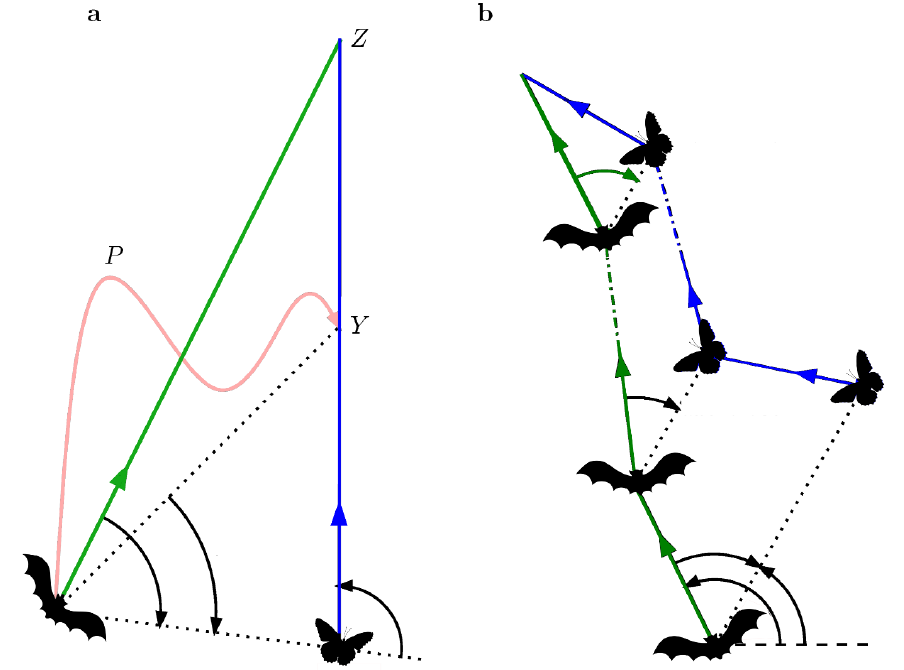
Figure 3. Modified from Ghose et al. 2006 [67]. ( a ) Constant bearing strategy (CB). Target (insect) moves in a straight line, at a constant velocity (blue line), and is pursued by bat that holds a fixed target bearing (green line), aiming where it will intercept the target (interception point Z). An alternative nonlinear path (pink) can be adopted by the bat when pursuing a target with constant linear velocity, resulting in a shorter intercept time at point Y (see Ghose et al. 2006 for further description). ( b ) Constant Absolute Target Direction strategy (CATD). Target (insect) moves erratically, by changing both direction and speed along path (blue). True erratic target motion cannot have a global time-minimum intercept, but can be approximated by infinite constant velocity segments. The bat’s path (green) can follow a locally time-optimal path by adjusting its flight trajectory to minimize changes in the absolute direction of the target. This strategy relies on the target position update acquired from returning echoes.